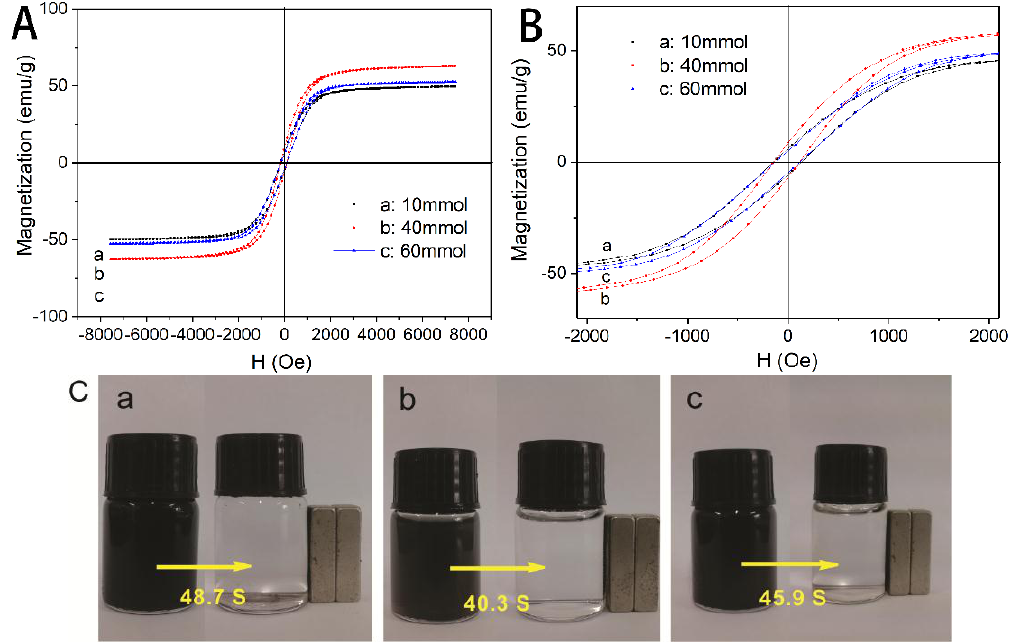
Figure 8. The hysteresis loops at T = 300 K of Fe 3 O 4 ( A ) and corresponding partly amplification images ( B ) with different molar ratio of NaAc ( a ) 10 mmol, ( b ) 40 mmol, ( c ) 60 mmol; ( C ) photograph showing magnetic isolation.